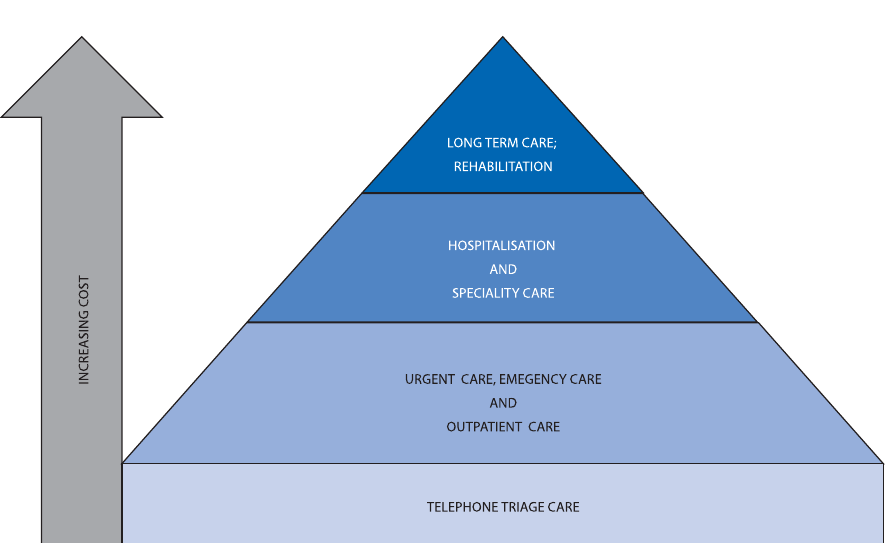
Figure 2: Conventional triage pyramid with telephone triage care as the